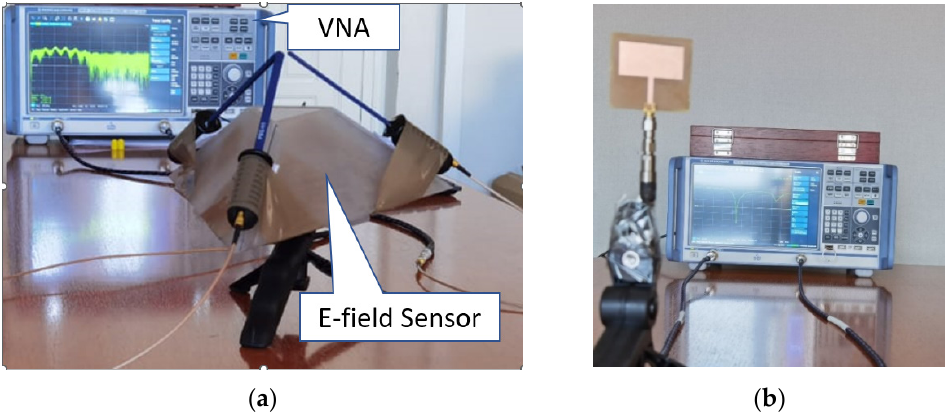
Figure 4. ( a ) S parameters measurement setup; ( b ) S11 measurement setup for the patch antenna.